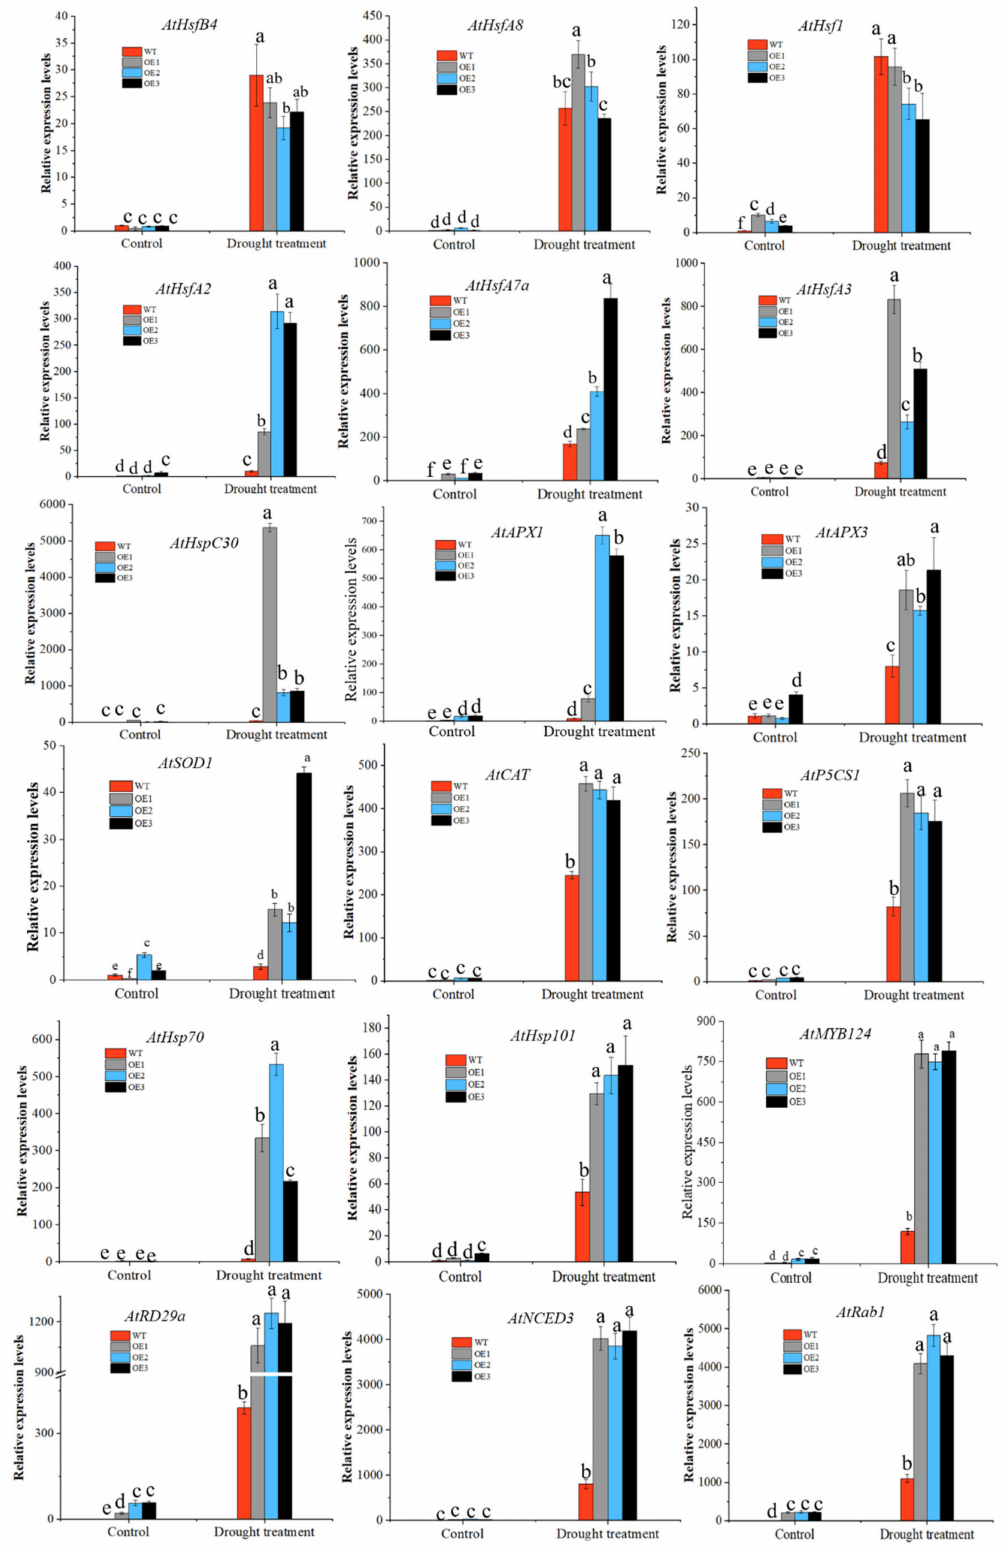
Figure 7. Expression pattern of stress–response genes in wild-type (WT), OE1, OE2, and OE3 lines before and after 10 days of drought treatment. Data are means with standard deviations of three biological replicates. Different letters denote statistical significance ( p ≤